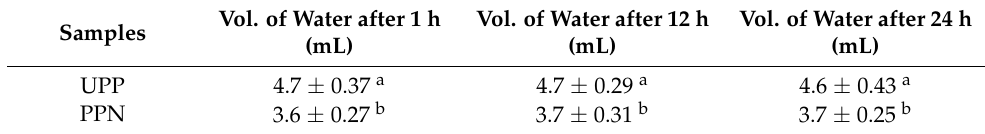
Table 2. Emulsion capacity of both UPP and PPN.